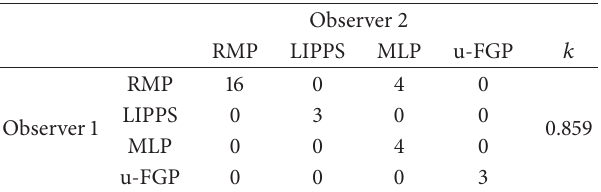
Table 4: NBI-ME pattern types and interobserver agreement for diagnosing